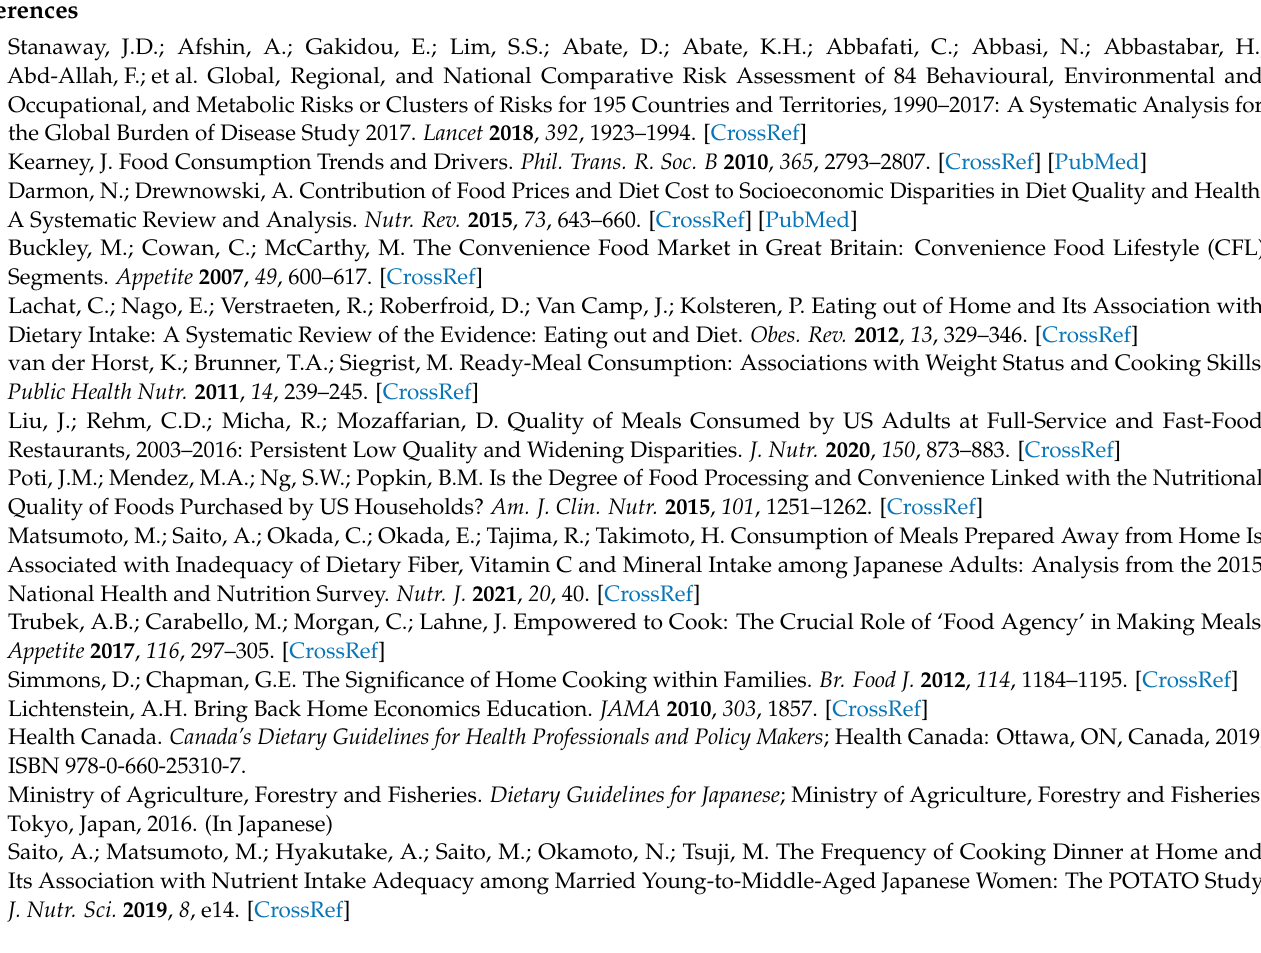
Table S4: Methods of assessing “home cooking”; Table S5: Quality assessment of the included